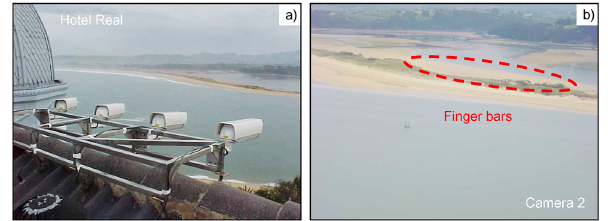
Figure 3. Horus video system. (a) Cameras on the roof of Hotel Real. (b) Image taken by camera